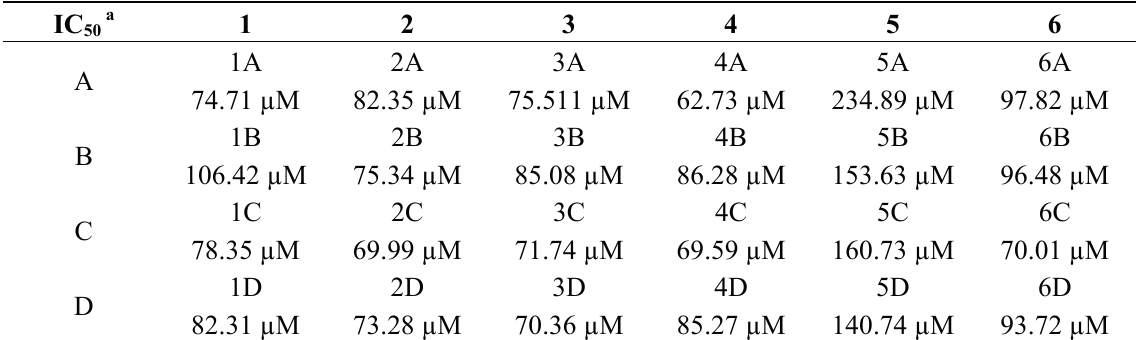
Table 2. Antiproliferative activity of compounds 1 – 24 against MCF-7 breast cancer